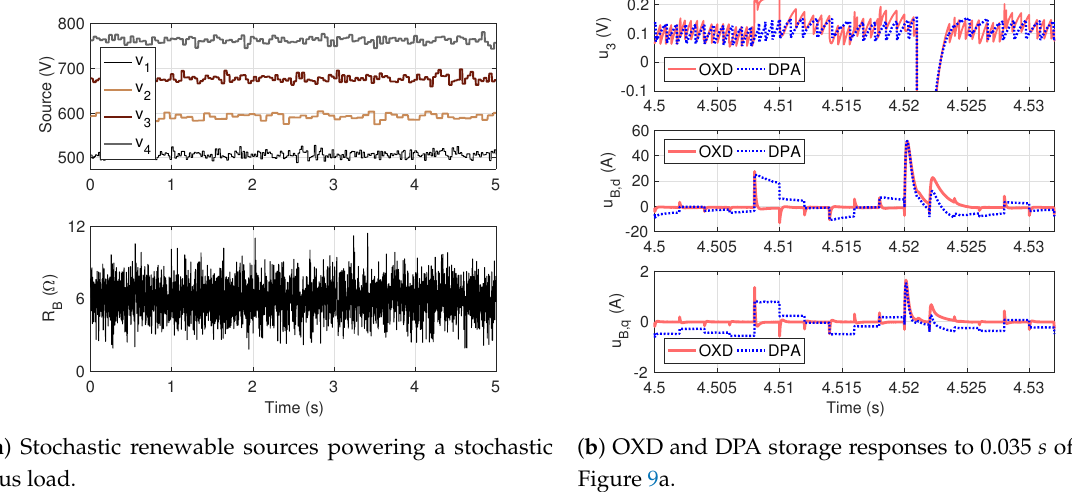
Figure 9. Scenario 3: ( a ) Stochastic renewable sources powering a stochastic bus load and ( b ) a small portion of the corresponding OXD and DPA storage responses. For clarity, only source storage u 3 was plotted.